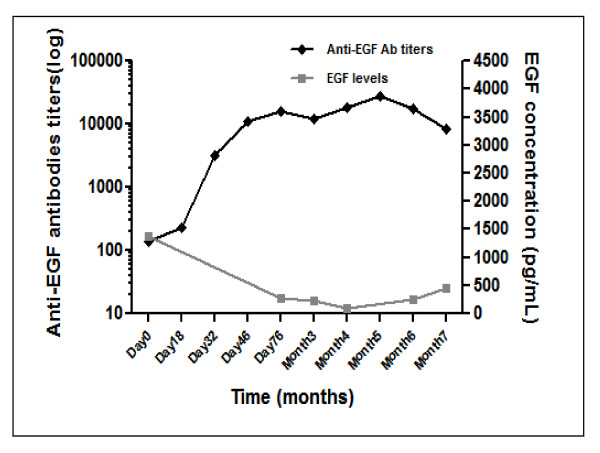
Kinetic of Anti EGF antibodies and serum EGF concentrations in the Phase III Trial (Vaccination with high dose/4 anatomic sites). The anti-EGF antibody titer was inversely correlated to the EGF serum concentration (spearman r correlation, p < 0.05). in this high dose/multiple sites study the decay below the 500 pg/mL threshold had effect after 76 days of vaccination.